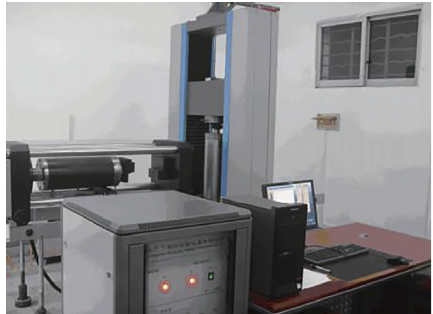
Figure 1: The microcomputer-controlled rock shear rheological tester